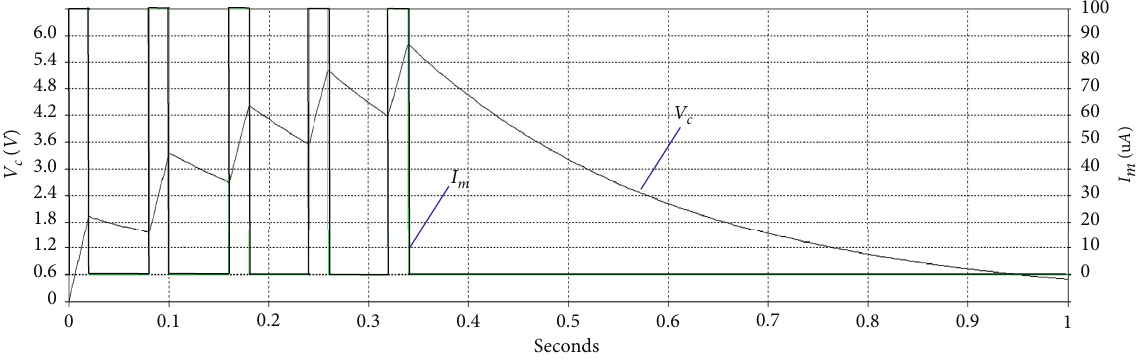
Figure 6: Variation of V ( t ) (memory) with time for a given current input c